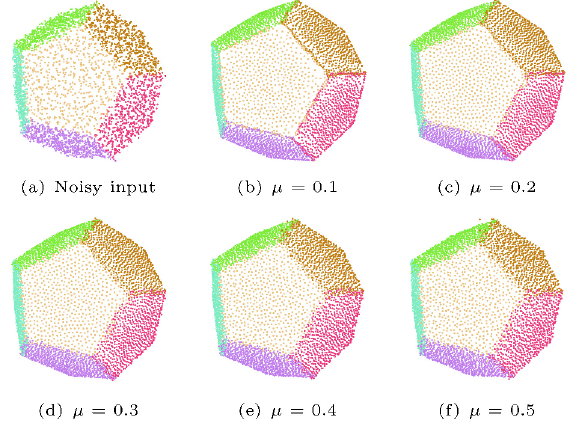
Fig. 14 Filtered results for different µ . Noise level: 1.0%, t = 30, k = 30.